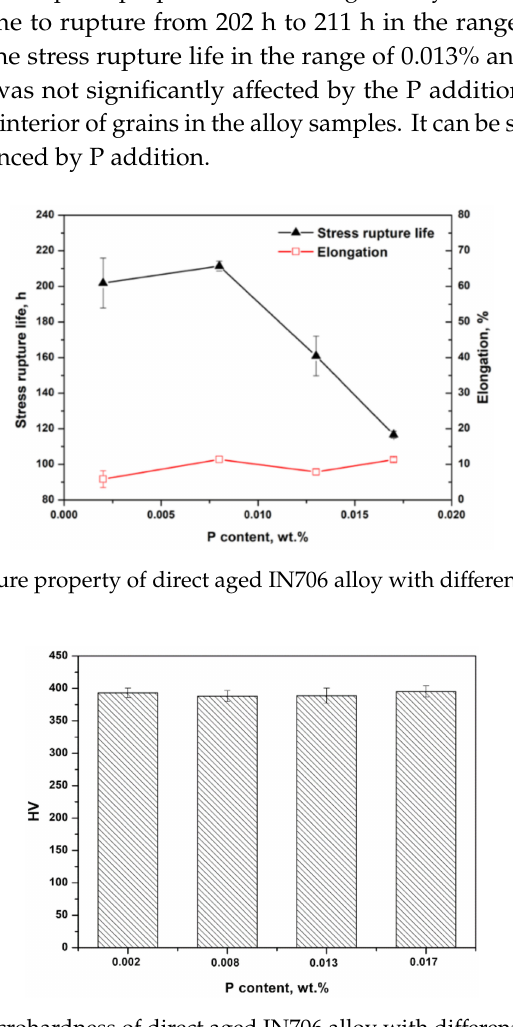
Figure 6. Microhardness of direct aged IN706 alloy with di ff erent P